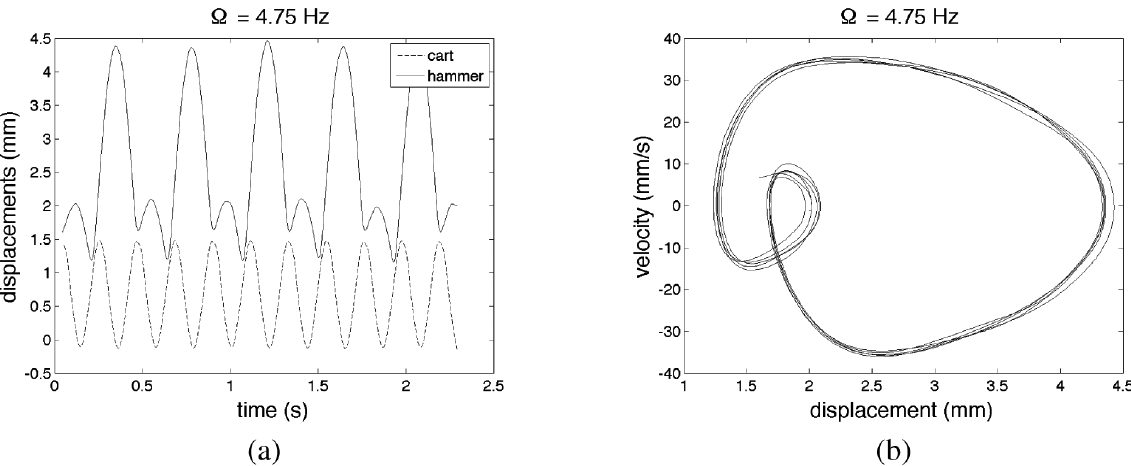
Fig. 6. Gap 0.0 mm. System undergoes a bifurcation. Excitation frequency 4.75 Hz: a) Displacements; b) Hammer phase plane.